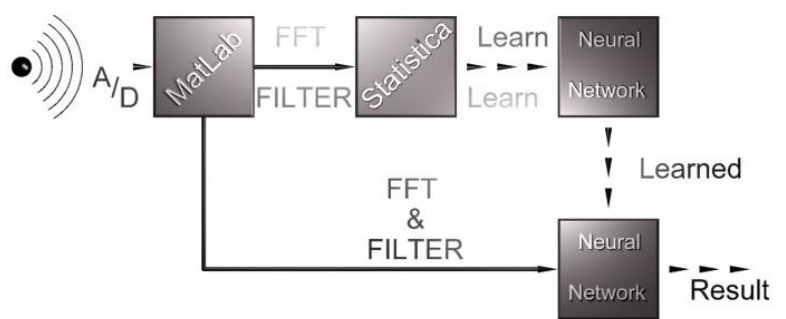
Figure 6. Schematic of the measurement